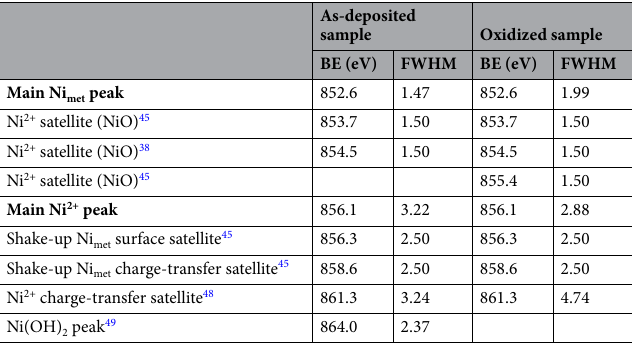
Table 1. Binding energy (BE) and full width at half maximum (FWHM) values of different Ni met and Ni 2+ components used for the fittings of the Ni 2p 3/2 spectra obtained for the as-deposited Ti 4 nm/Au 60 nm/Co 1 nm/Ni 2 nm layer and the layer subjected to plasma oxidation.